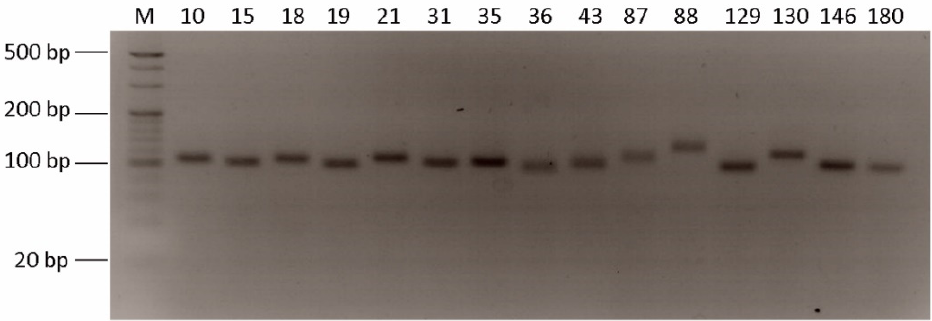
Figure 3. PCR products of microsatellite in T. loennbergii . M is the 20 bp DNA marker and 4% agarose gel electrophoresis was used. The number is primer pairs order.